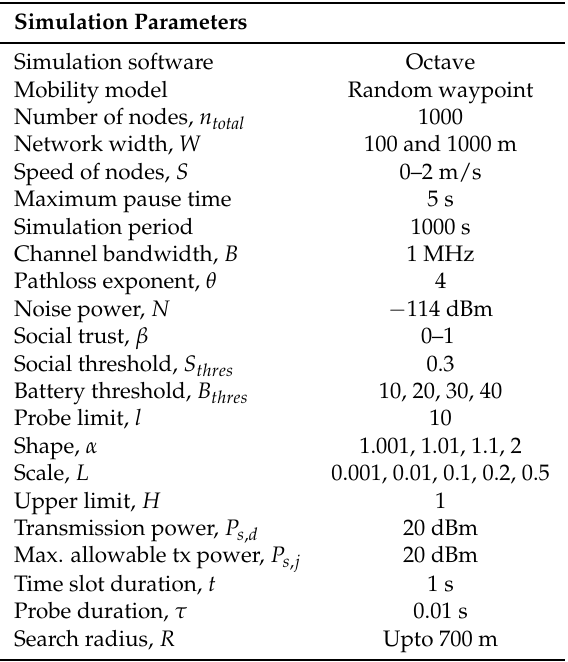
Table 1. Simulation setup for analysis of